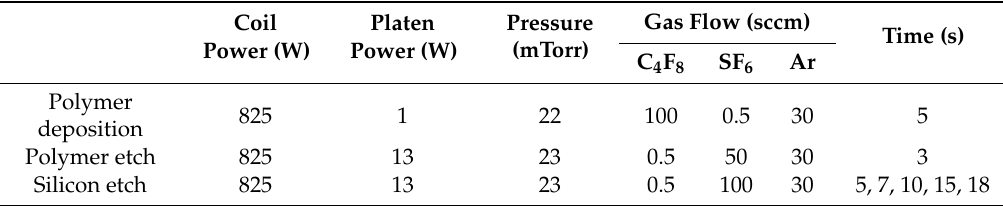
Figure 2. Fabrication process flow. ( a ) TEOS deposition; ( b ) PR patterning using UV lithography; ( c ) TEOS patterning; ( d ) PR removal; ( e ) DRIE for fabricating protrusion and support structure; ( f ) wet oxidation for nanowire fabrication and layer-to-layer isolation. Table 1. DRIE process steps for process development. Table 1. DRIE process steps for process development.